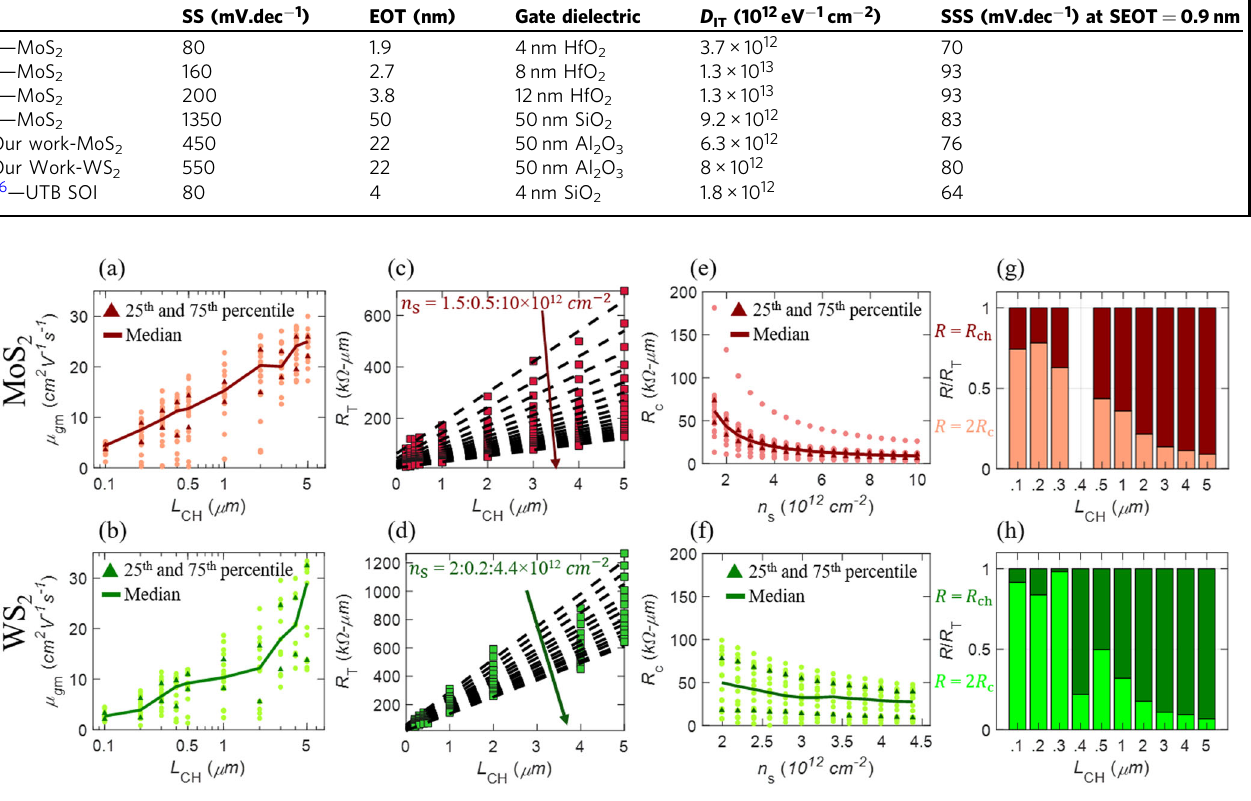
Fig. 5 Device-to-device variation in fi eld-effect mobility and contact resistance. Distribution of mobility extracted using peak transconductance ( μ different channel lengths for a MoS 2 and b WS 2 FETs. Median, 25th percentile, and 75th percentile is also denoted. Total resistance ( R T ) versus L CH for c MoS 2 and d WS 2 for different carrier concentrations ( n S ) extracted using a representative TLM structure. The distribution of contact resistance ( R c ) across multiple TLM structures, extracted from the y-intercepts in c and d , as a function of n S for e MoS 2 and f WS 2 , respectively. The relative contribution of R c and channel resistance ( R ch ) to the total resistance for g MoS 2 and h WS 2 for different L CH . In scaled devices, as R ch scales with the channel length, the contribution of R c (note that R c is independent of L CH ), i.e., 2 R c / R T , is more signi fi cant compared to R ch , i.e., R ch / R T